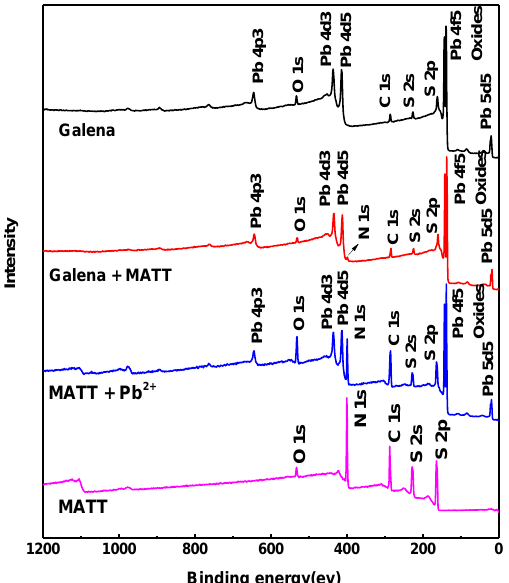
Figure 8. The survey XPS spectra of galena, galena treated with MATT, MATT and MATT treated with Pb 2+ ions. Table 1. Atomic concentrations of galena samples before and after treatment by